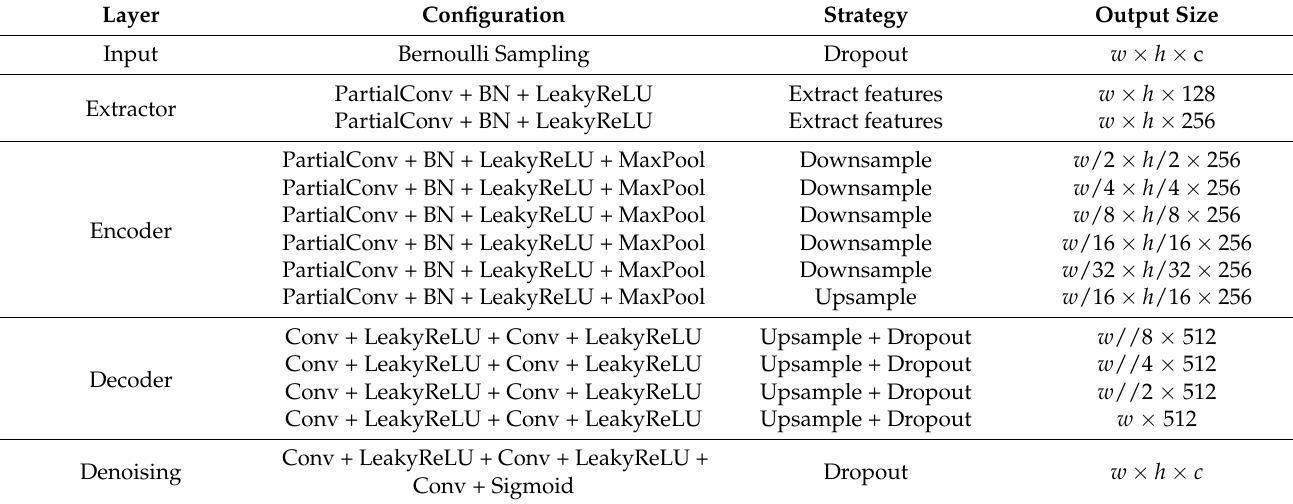
Table 1. Network structures of 3S-HSID.